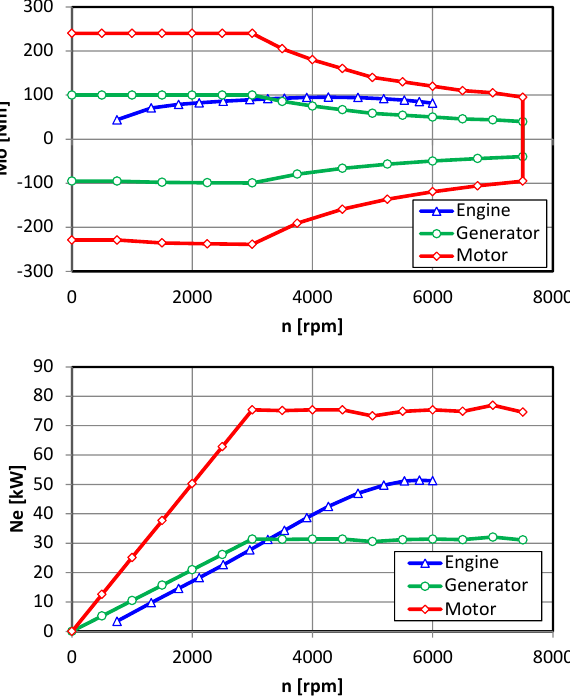
Fig. 2. Characteristics of the electric motor, generator and engine: a) torque, b) power